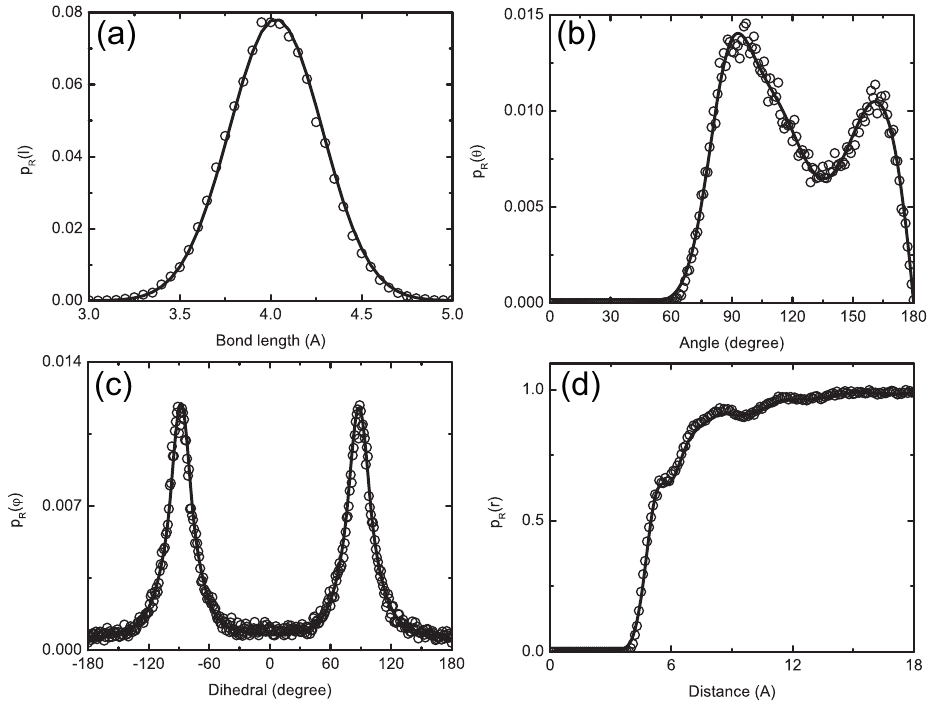
Figure 8. Distribution functions for ( a ) bond length; ( b ) bond angle; ( c ) dihedral angle; and ( d ) pair distance of all atomistic (solid lines) and coarse-grained (dots) models of cis -polyisoprene (PI) melts at 413 K. Figure reproduced with permission from [92].